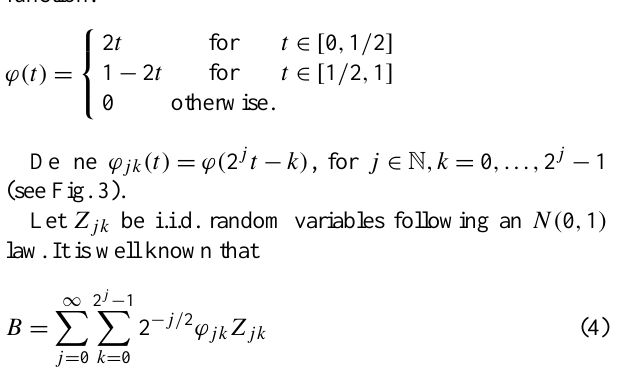
One can show that Λ α ′ ,β ′ possesses a unique fixed point,